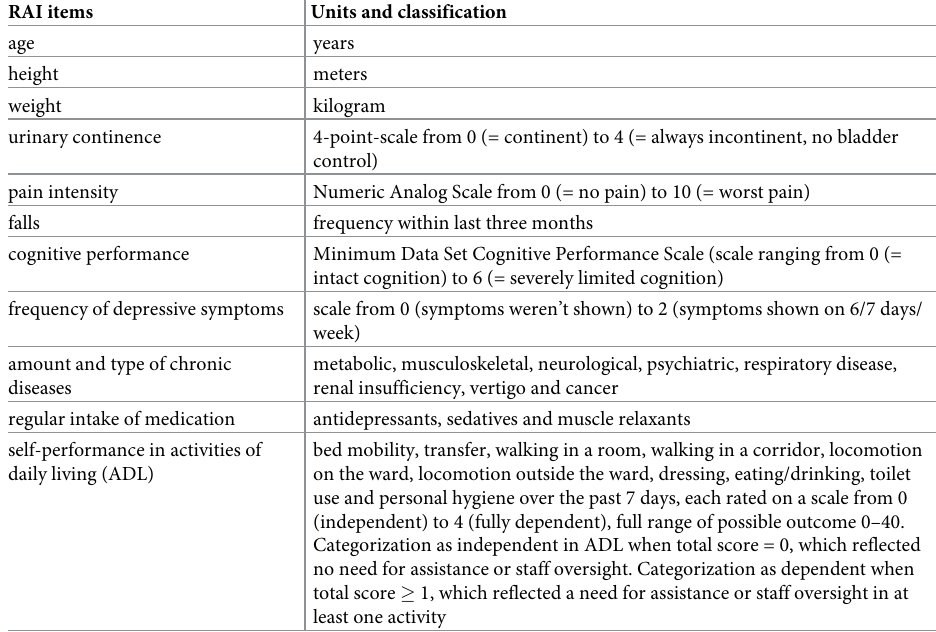
Table 1. Items of the Resident Assessment Instrument obtained from the study